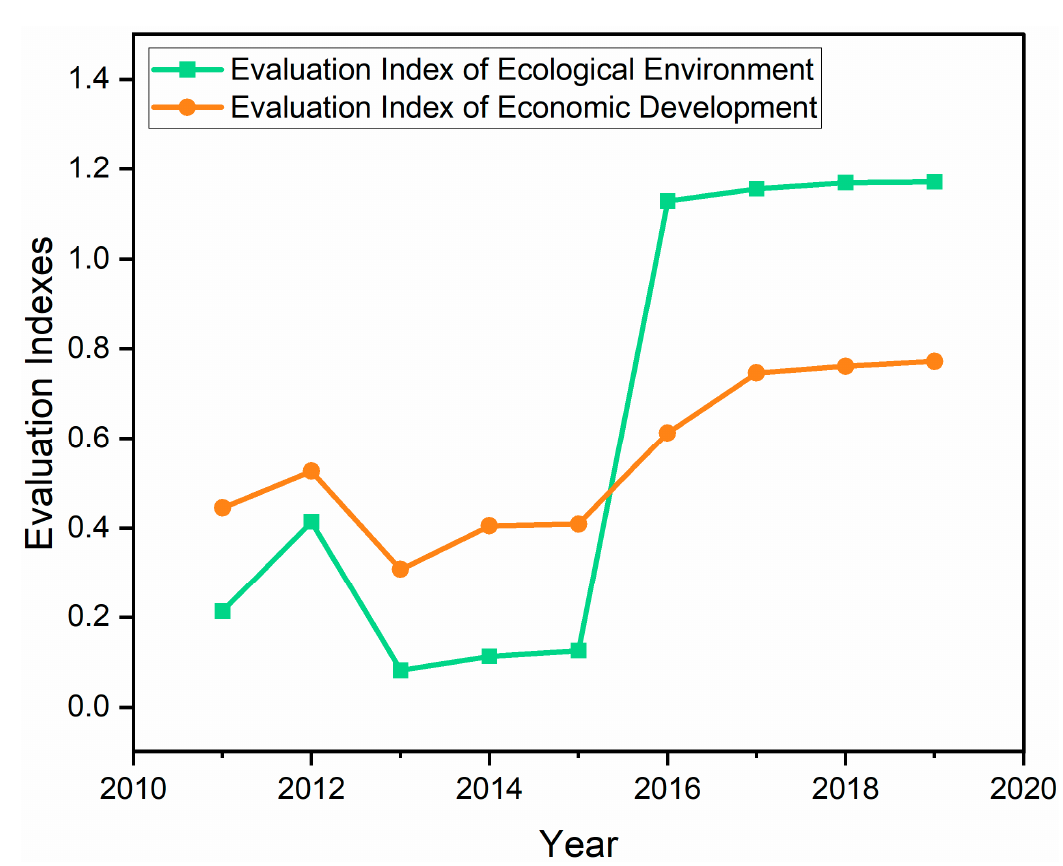
Figure 2. Change trends in the evaluation index of the environment and economic development from 2011 to 2019.